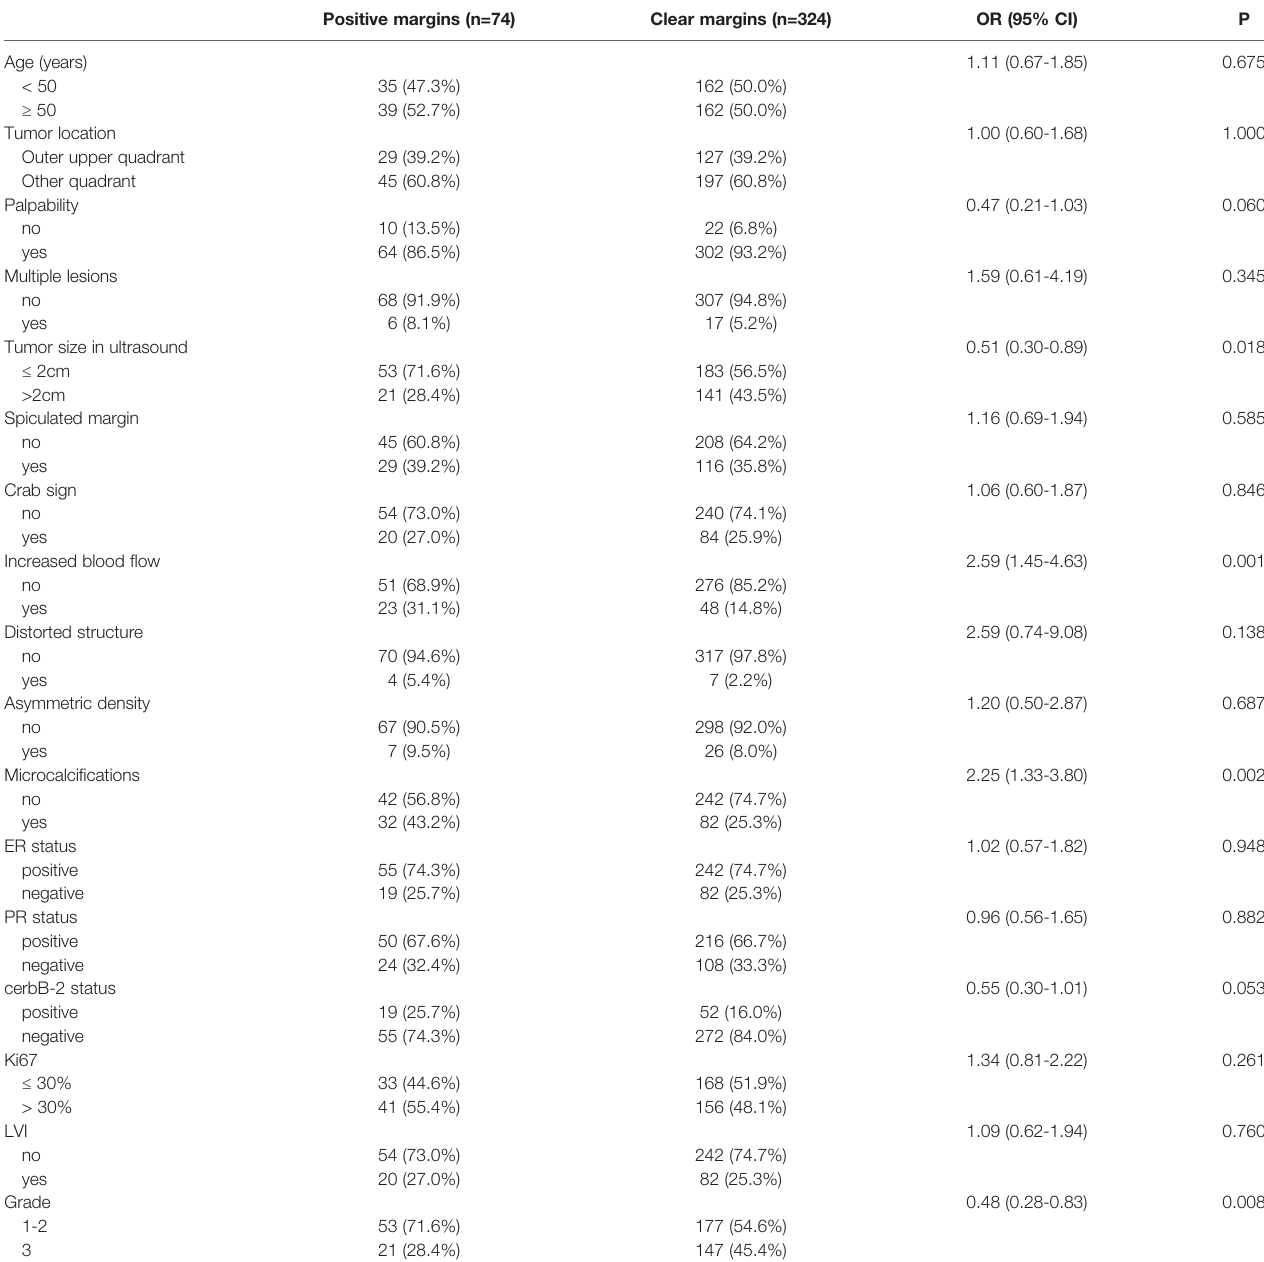
TABLE 2 | Comparison of variables with clear and positive resection margins in the study cohort. Positive margins